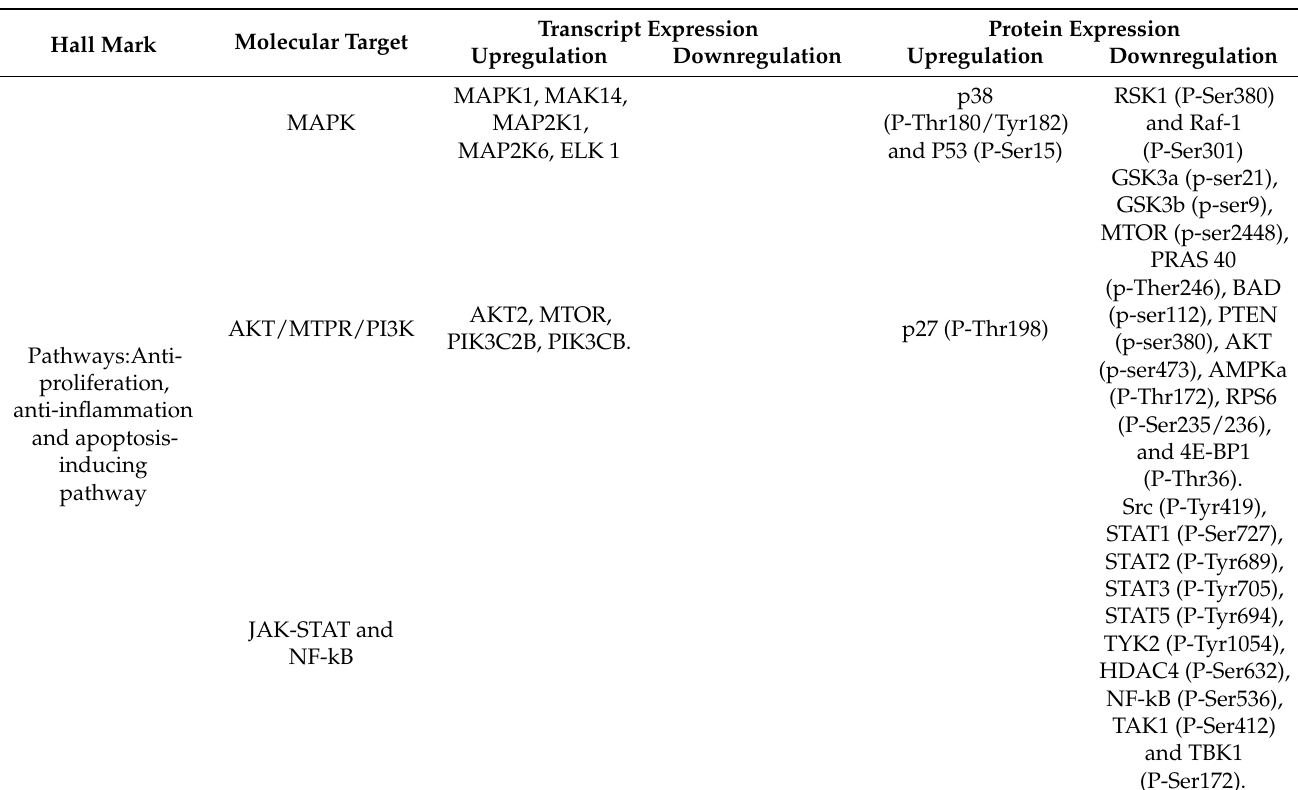
Table 2. Table showing fisetin-mediated modulation of various signalling pathways by altered expression of different genes and phosphorylated